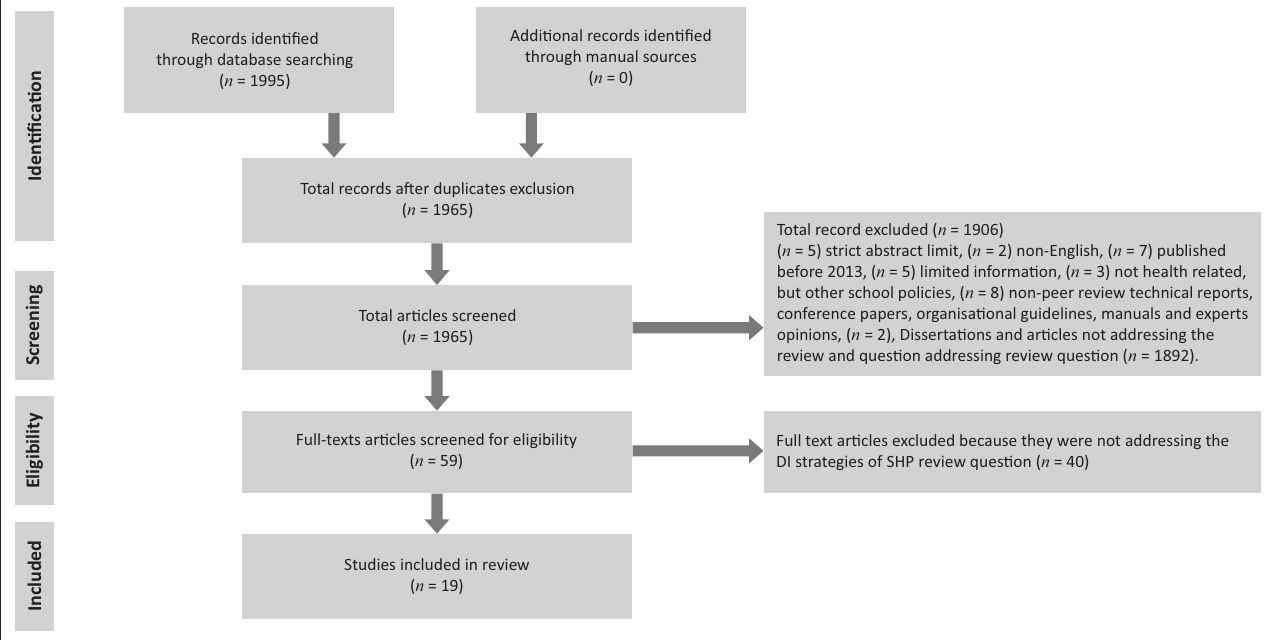
FIGURE 1: Preferred reporting items systematic and meta-analysis flow diagram of search